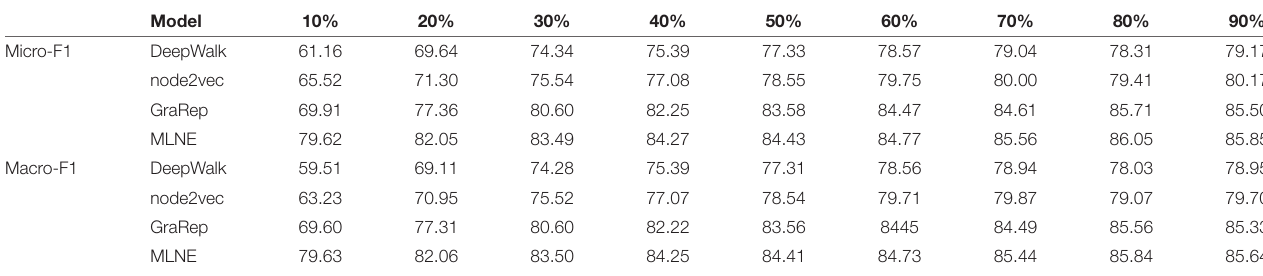
TABLE 4 | Node classification results on 20-NEWSGROUP.